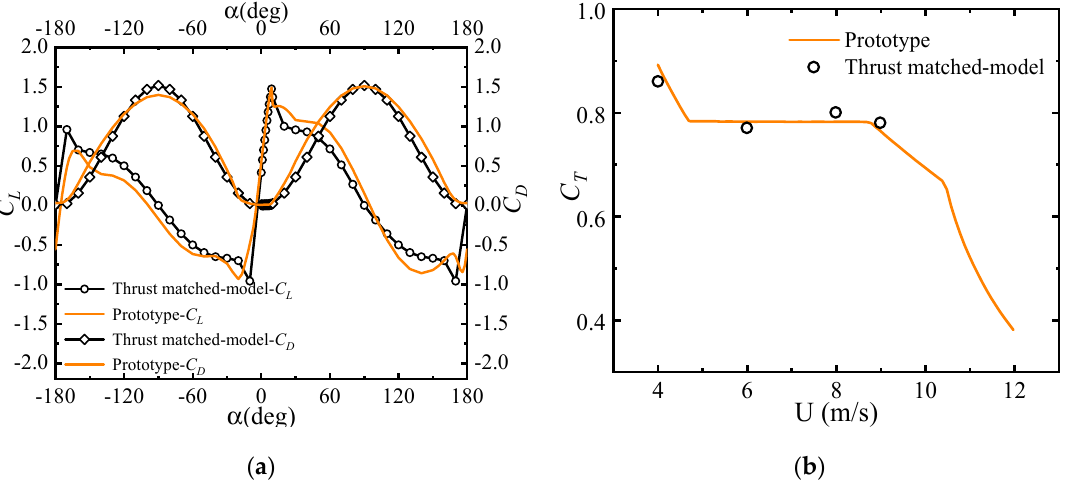
Figure 5. Comparisons of aerodynamic forces of scaled wind turbine models with the thrust- optimized blades. ( a ) Lift coefficient ( C L ) and drag coefficient ( C D ) of the blade airfoil; ( b ) thrust coefficient ( C T ) of the scaled wind turbine